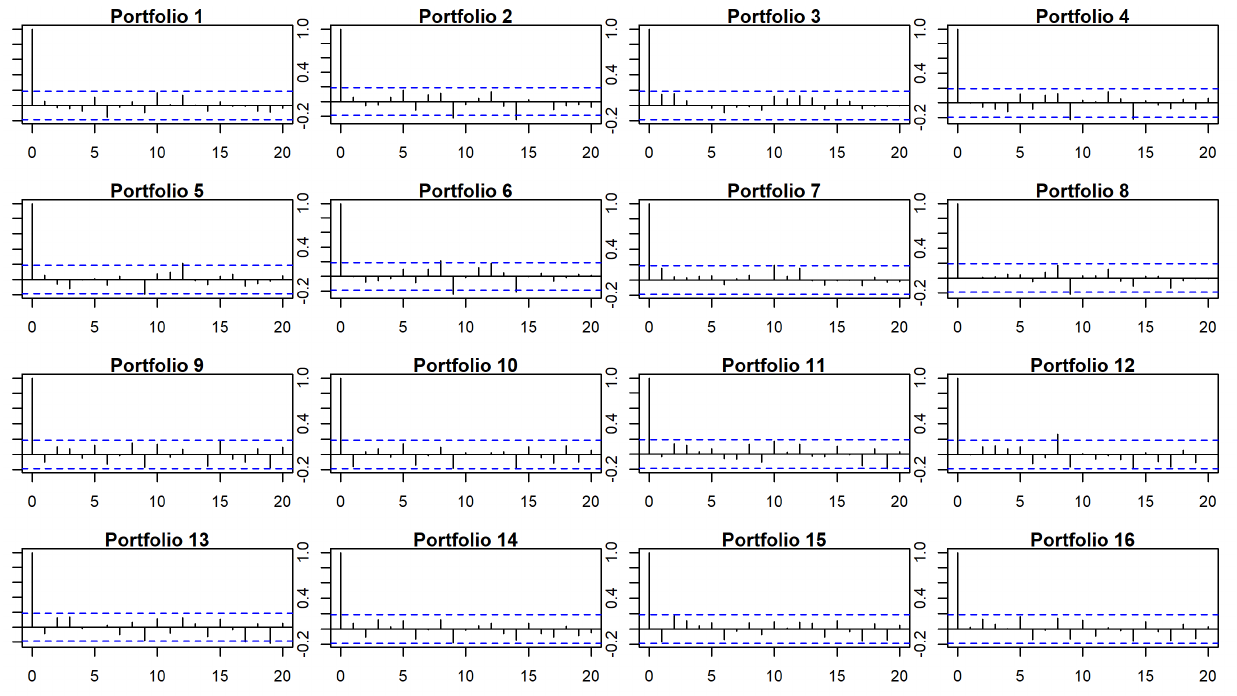
Figure 3. Autocorrelation charts for errors in TS regression for CAPM for the whole